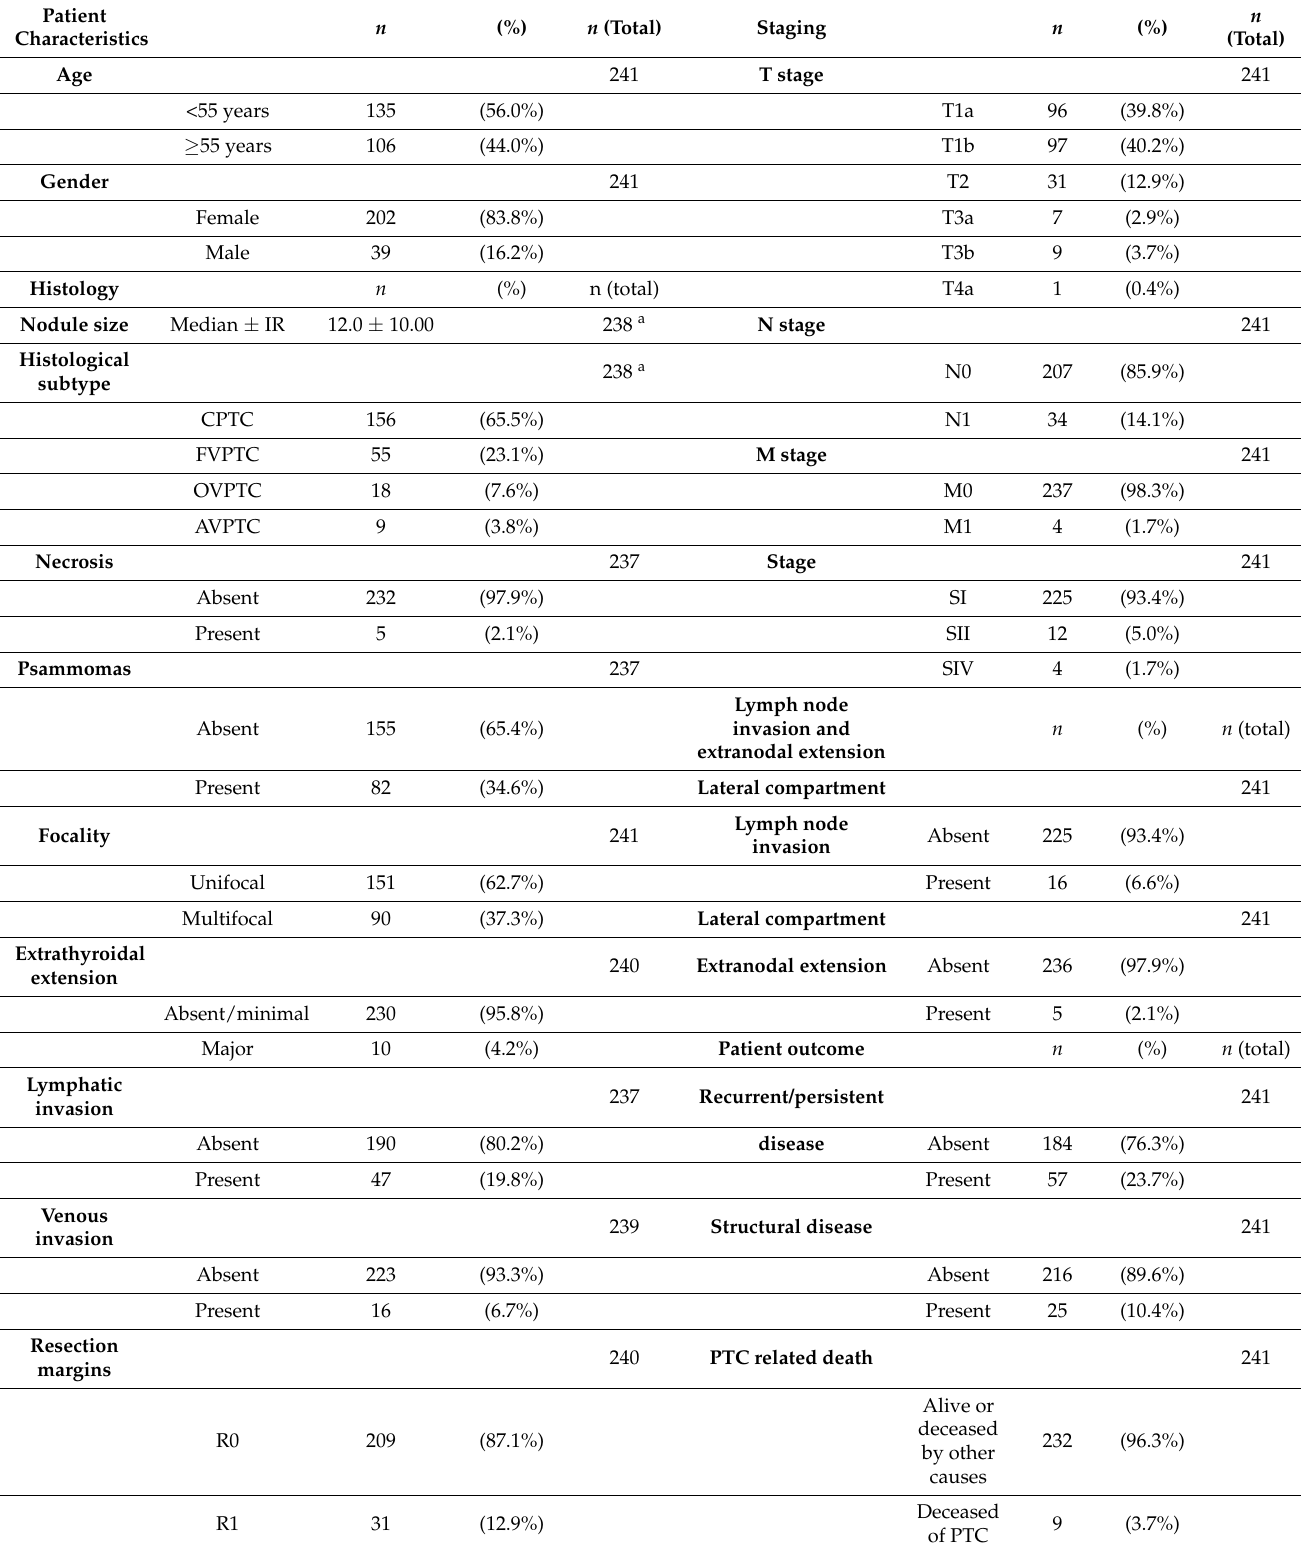
Table 1. Series description: patient characteristics, tumor histology, staging, lymph node metastases, and patient outcome. Patient